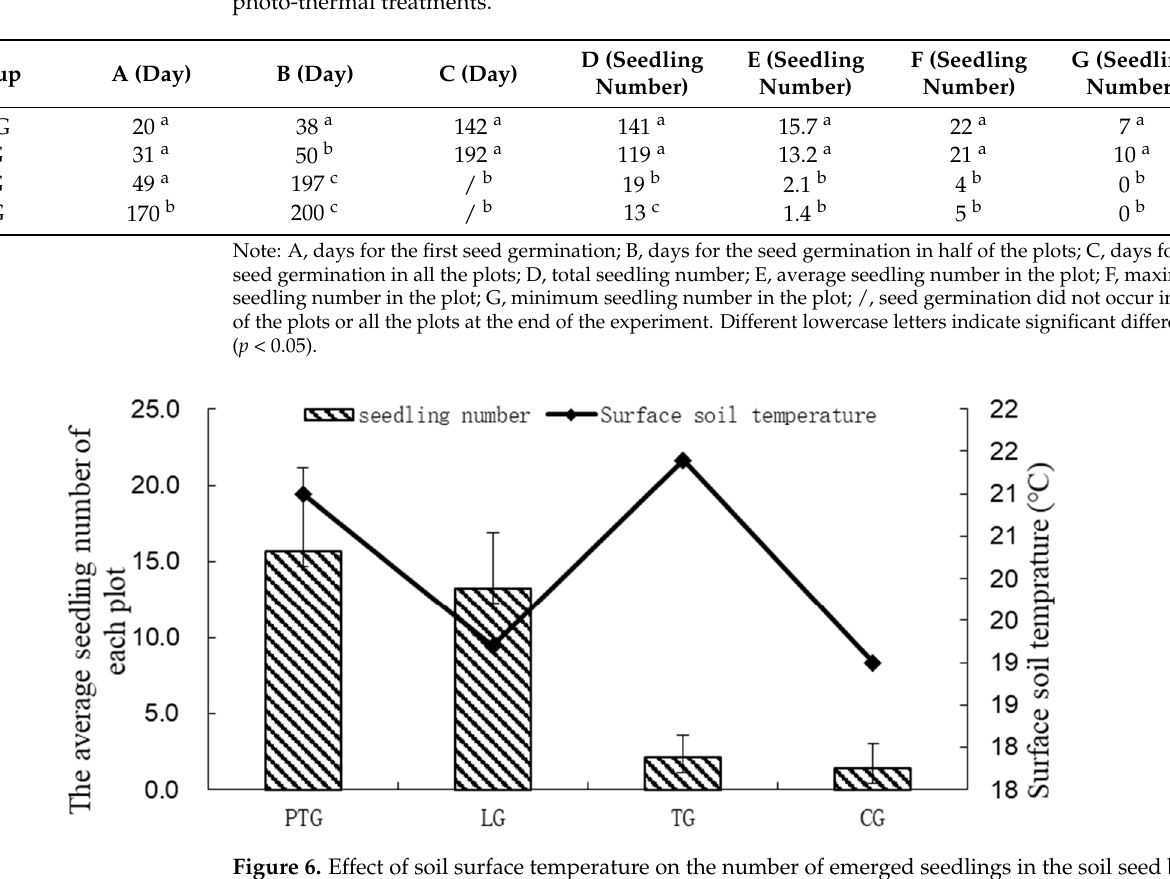
Table 3. Comparisons of the seed germination characteristics in the soil seed bank under different photo-thermal treatments.